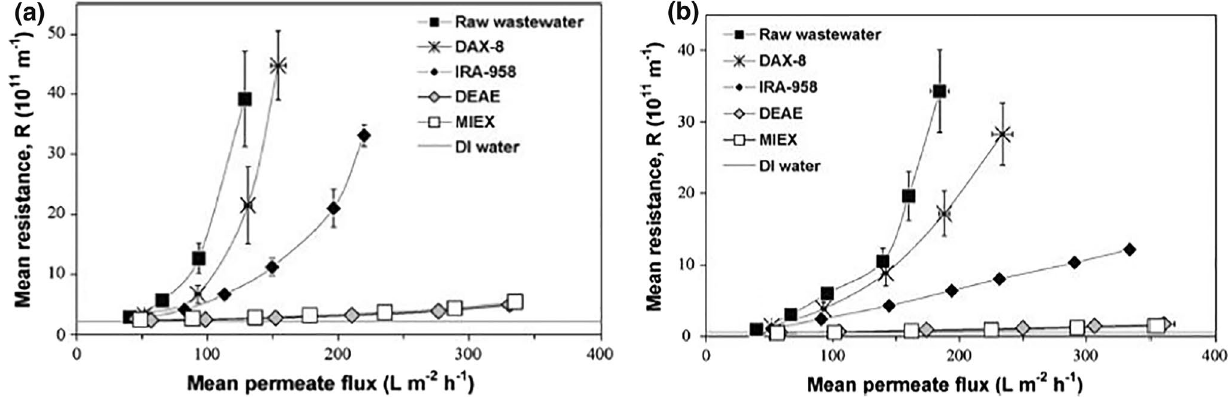
Fig. 7 Fouling resistance of UF a and microfiltration (MF) membranes b during filtration of wastewaters after pretreatment with various IXR (Abdulgader et al. 2013)